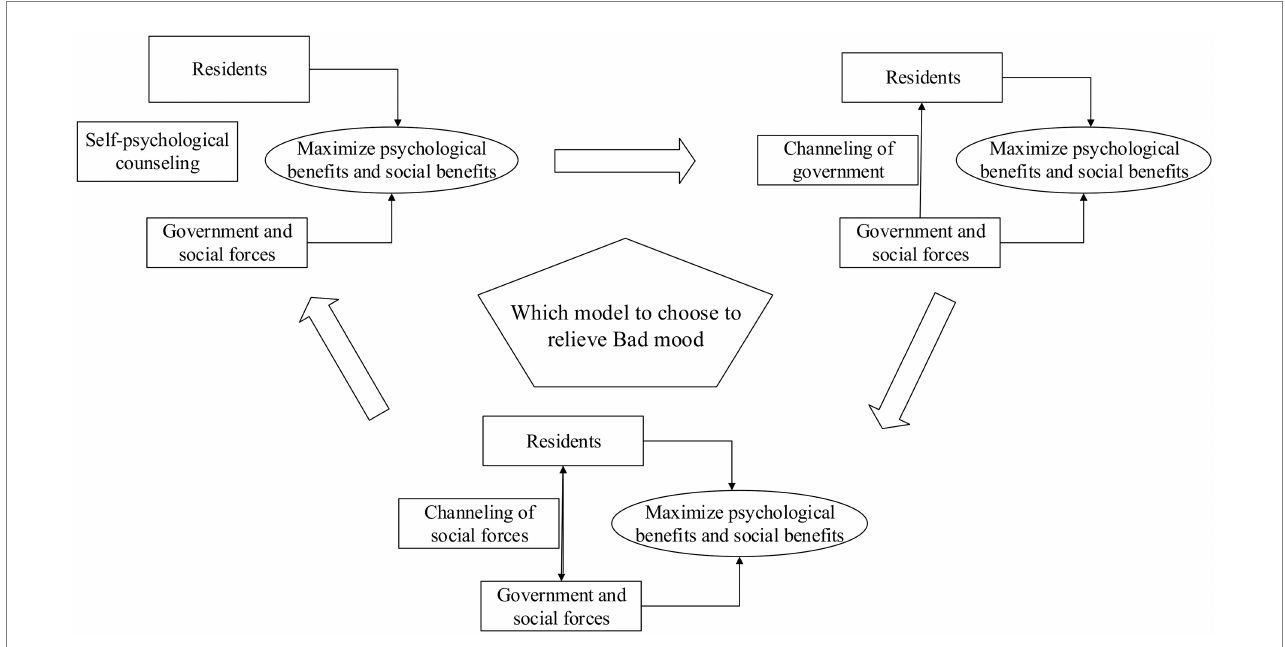
FIGURE 1 Various modes of psychological counseling for isolated